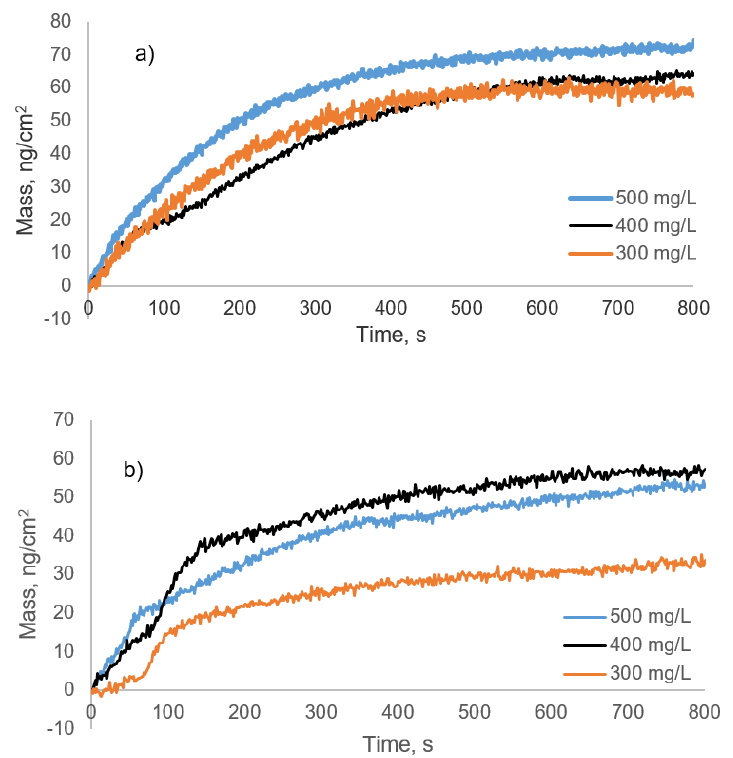
Figure 7. Kinetics of the mass deposition on the Al 2 O 3 surface for the adsorption of ( a ) SBL ( b )